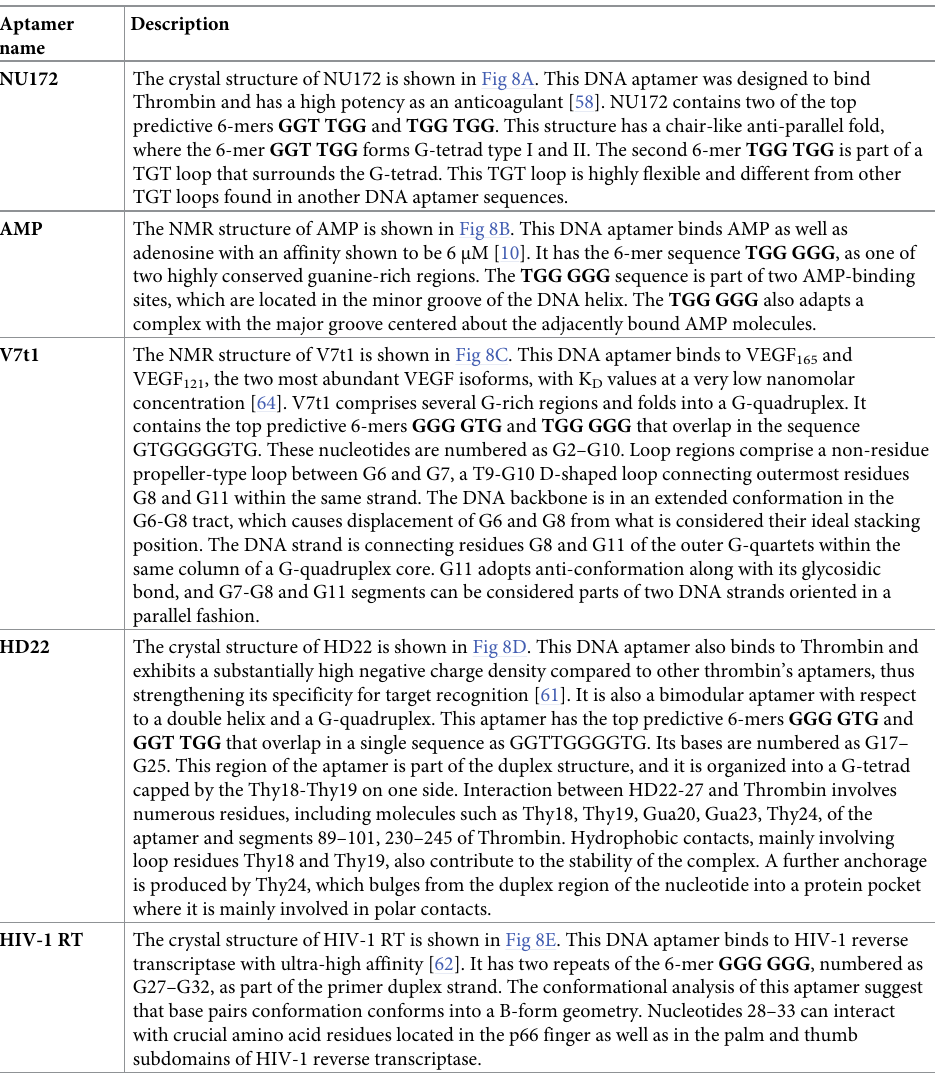
Table 5. Identification of the top 6-mers on elucidated aptamer